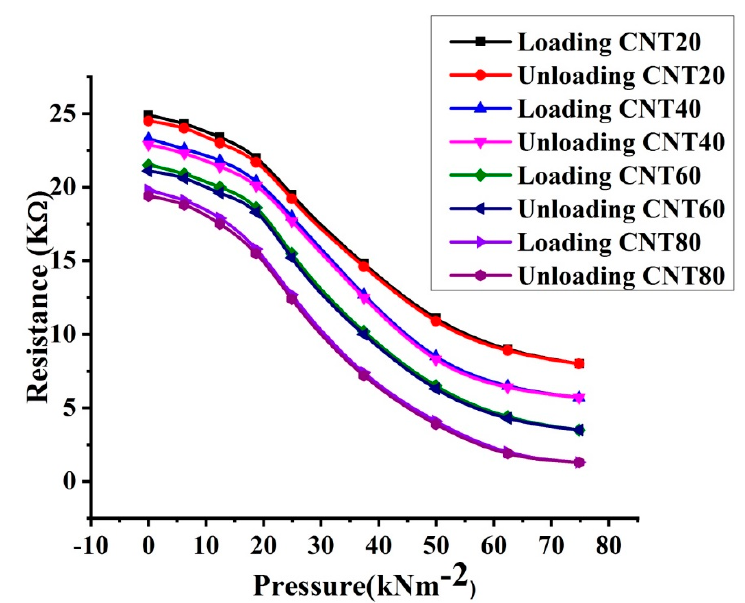
Figure 8. Resistance-pressure characteristics for CNT-graphene composite based piezoresistive pressure samples at loading and unloading with weight percentages 20, 40, 60, and 80 of CNTs.